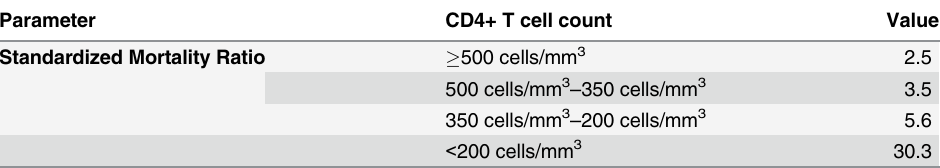
Table 5. Standardized mortality ratios for excess mortality due to HIV-1